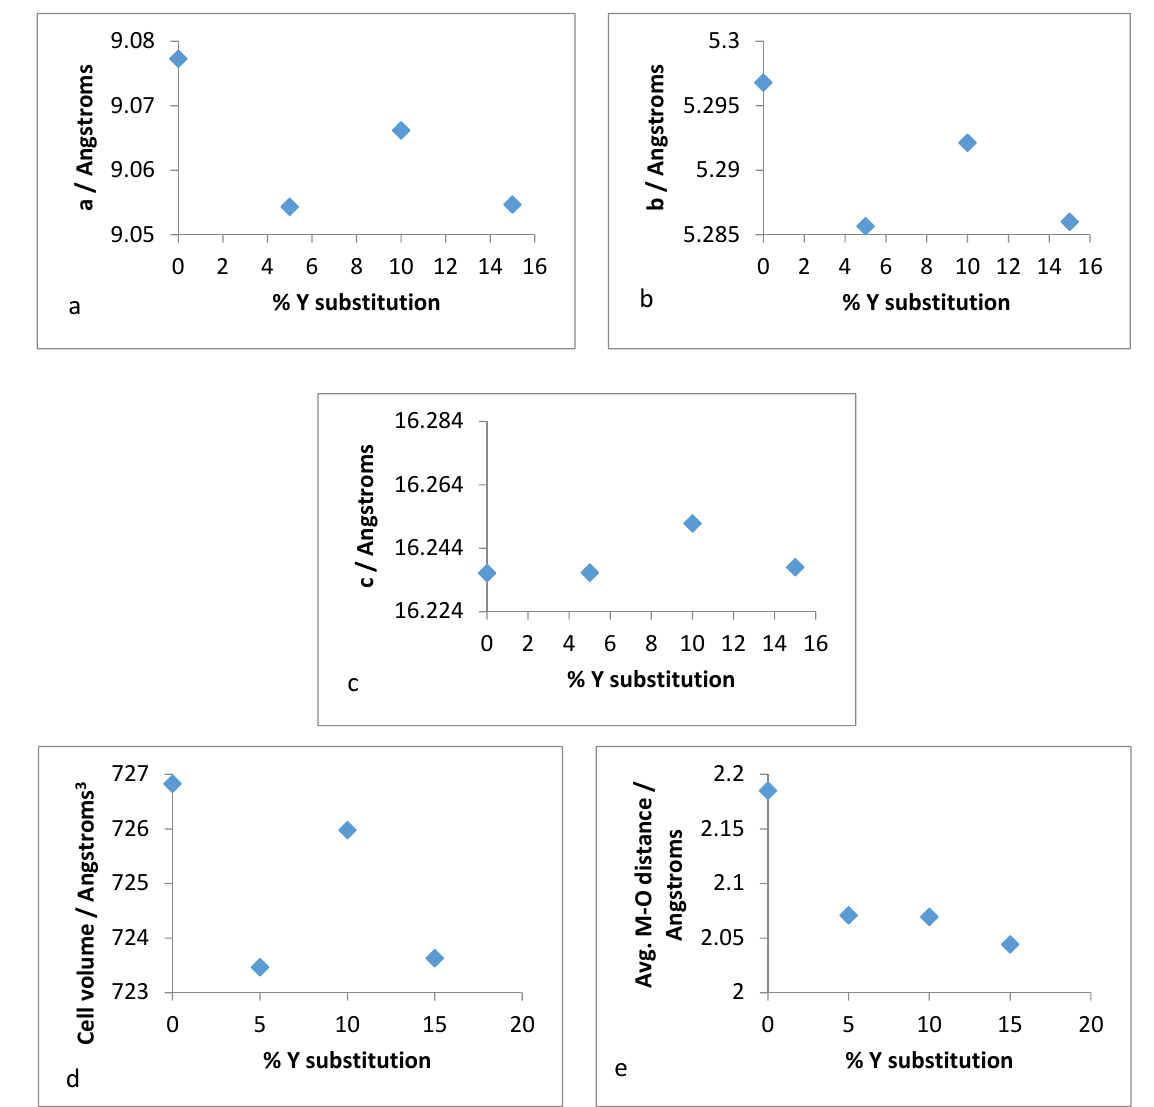
Figure 16. Unit cell parameters for: ( a ) a -axis, ( b ) b -axis, ( c ) c -axis, ( d ) volume and ( e ) mean M–O distance versus % Y substitution for conventional Y–ZrP.